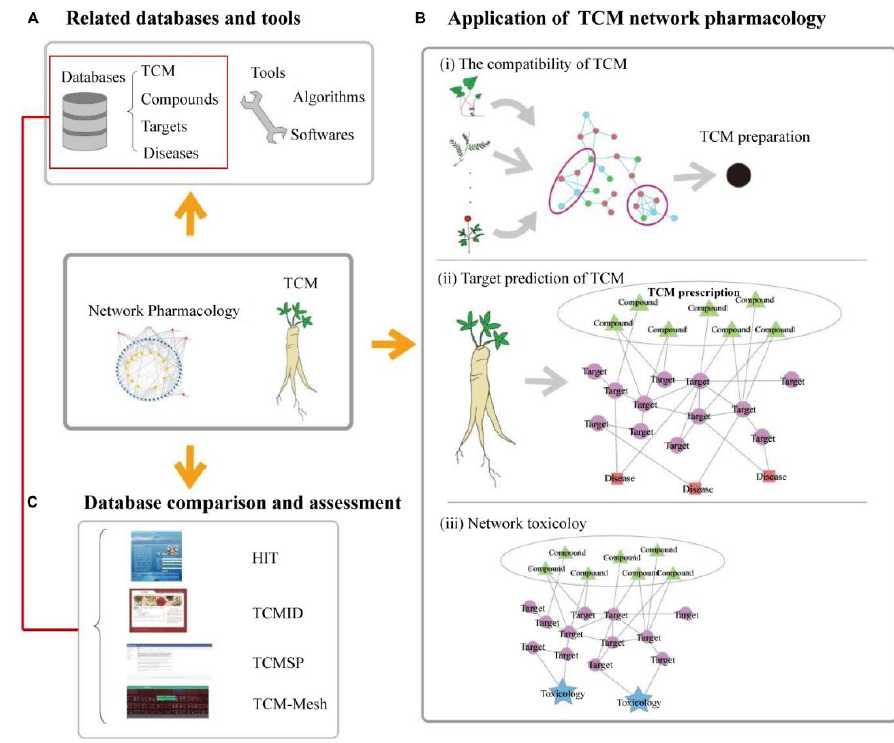
Figure 1. Example of network pharmacology applied to traditional Chinese medicine (TCM) formulae. ( A ) use of databases and bioinformatics for the identification of correlations between TCM, substances, targets and diseases; ( B ) building the pharmacological networks; ( C ) Database comparison and assessment. Distributed under the terms of the Creative Commons Attribution License (CC BY) Copyright © 2019 Zhang, Zhu, Bai and Ning [67].